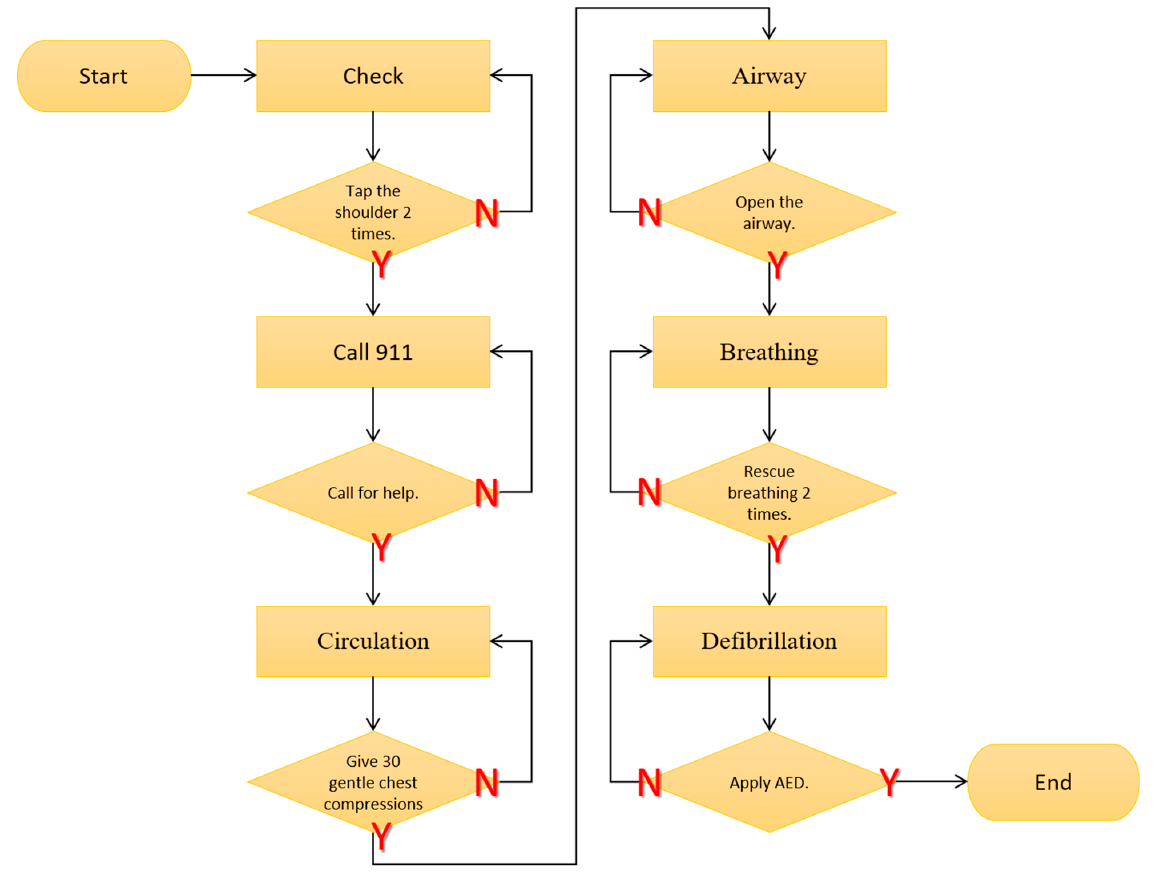
Figure 13. The flowchart of the instruction mode.